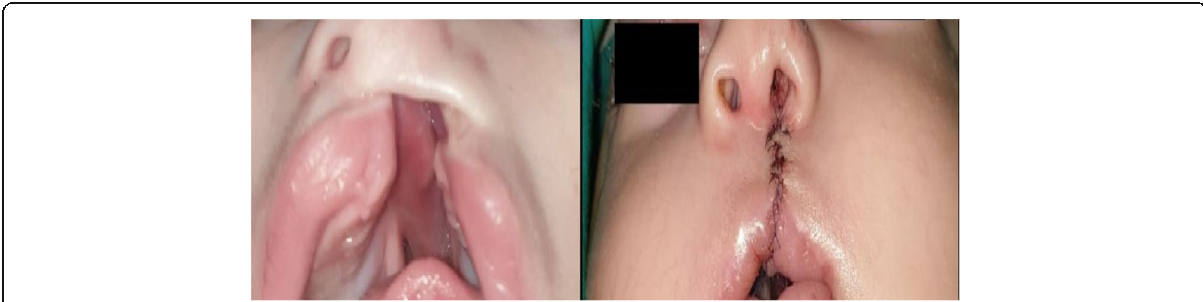
Fig. 1 Pre- and postoperative pictures of repair